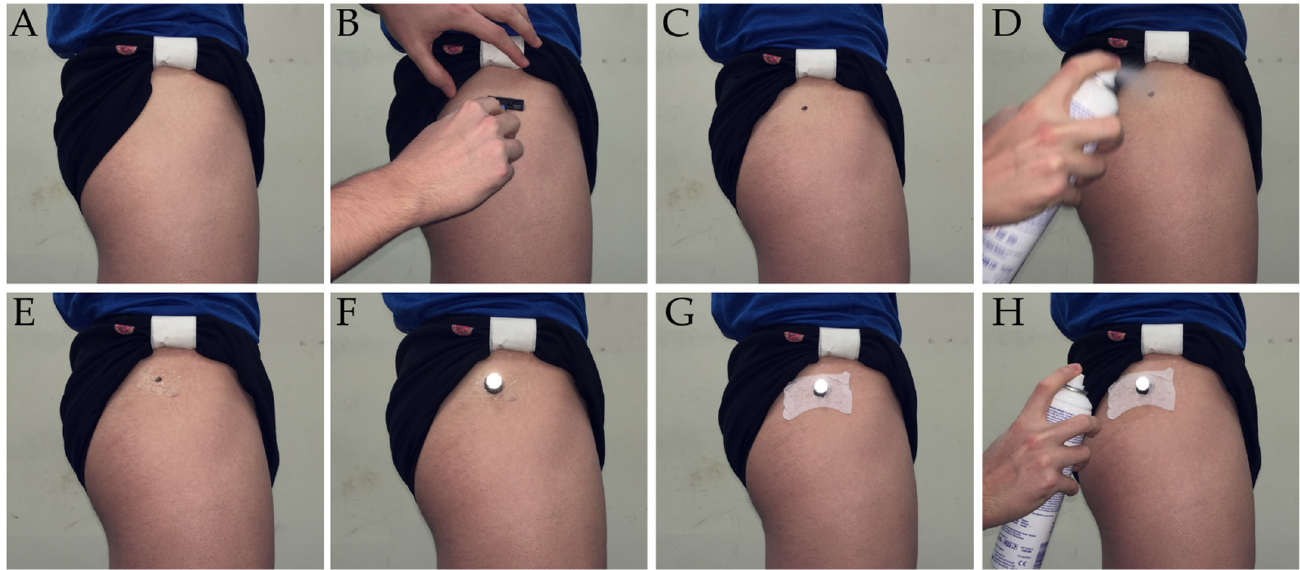
Figure 2. Protocol followed for fixing the retro-reflective markers. A: fit shorts, B: shave the area, C: mark the anatomical point, D: add adhesive spray, E: wait for it to dry, F: stick the marker, G: reinforce with a non-woven adhesive material, H: add adhesive spray again on the non-woven adhesive material.